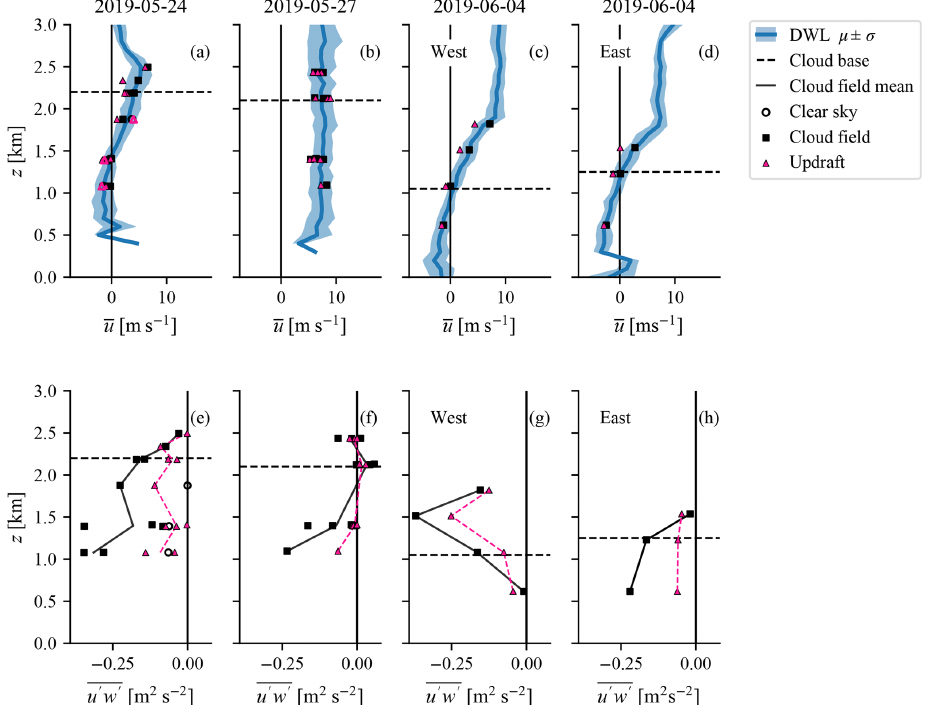
Figure 8. Average u (a–d) and u (cid:48) w (cid:48) (e–h) profiles for each flight date. The u axis is positive eastward. To obtain these profiles, we applied the same averaging procedure as in Fig. 5 and the eddy-covariance method as described in Sect. 2.1.3. On 24 May 2019 (a, e) , the clear-sky measurements are indicated with open circles, whereas measurements in cloud fields are indicated with filled squares. Pink triangles represent the wind speed within updrafts (upper panels) and updraft contribution to the total flux (lower panels).